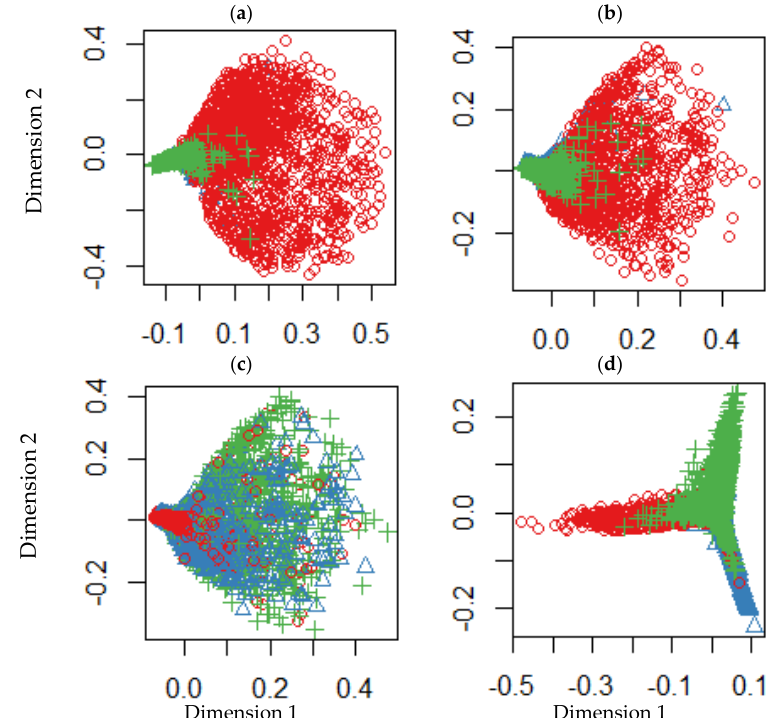
Figure A2. Random forest-based multidimensional score (MDS) plots for BCS prediction in 43–54-month-old ewes at different stages of the annual cycle (( a ) pre-breeding, ( b ) pregnancy diagnosis, ( c ) pre-lambing, ( d ) weaning). Red, blue and green circles represent single data points from BCS of 1.0–2.0, 2.5-3.5 and >3.5, respectively.